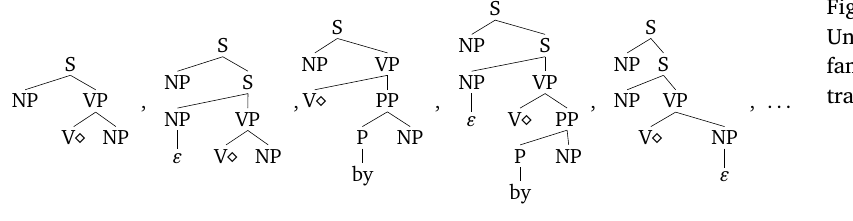
Unanchored tree family for transitive